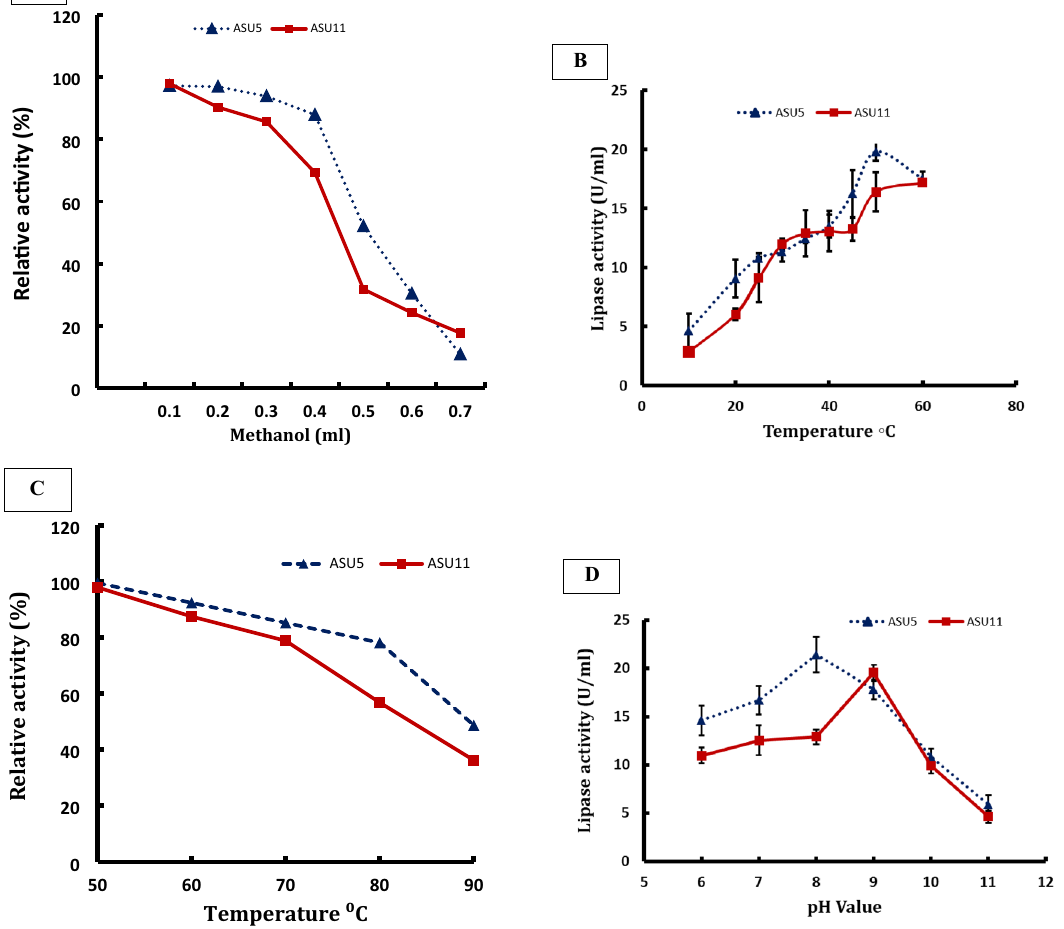
Figure 7. ( A ) Effect of methanol concentration on bacterial lipase activities. ( B ) Effect of temperature on bacterial lipase activities. The means value of three replicates ± SD (vertical bars) is represented. ( C ) Thermoactivity of lipases produced by bacterial strains Kocuria flava ASU5 and Bacillus circulans ASU11 (MT919306). ( D ) Effect of pH value on bacterial lipase activities. The means value of three replicates ± SD (vertical bars) is